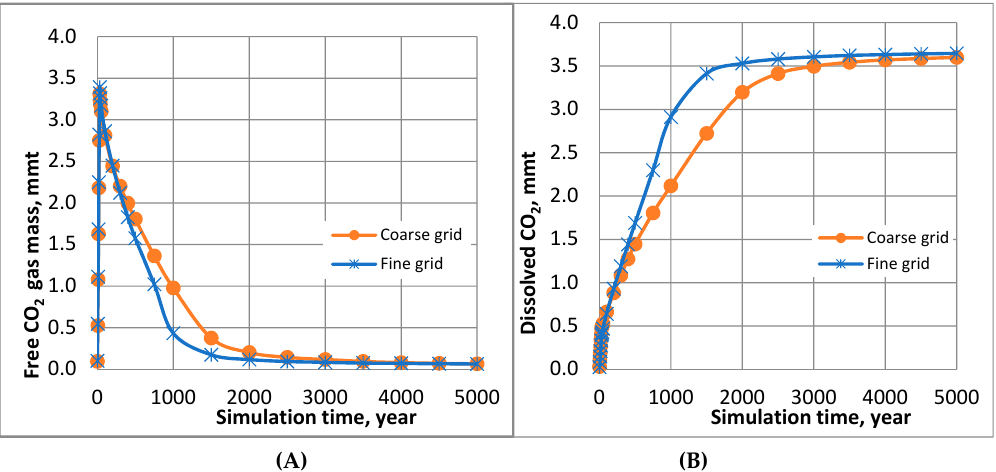
Figure 17. Effect of grid resolution for cases 5 and 6 in a homogeneous domain on: ( A ) dissolved CO 2 ; ( B ) free ‐ gas CO 2 .